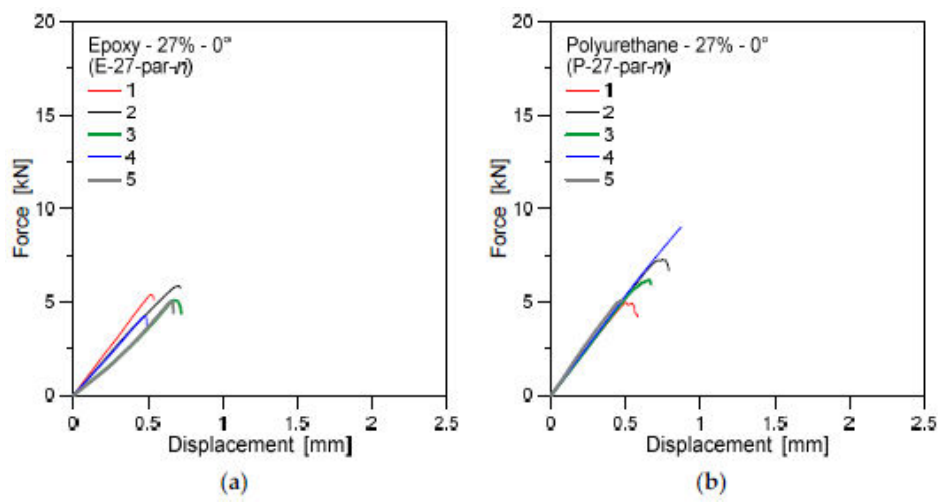
Figure A3. Experimental force–displacement results for specimens with ( a ) epoxy or ( b ) polyurethane glue, under 27% moisture and bonding and parallel rod-to-grain arrangement.